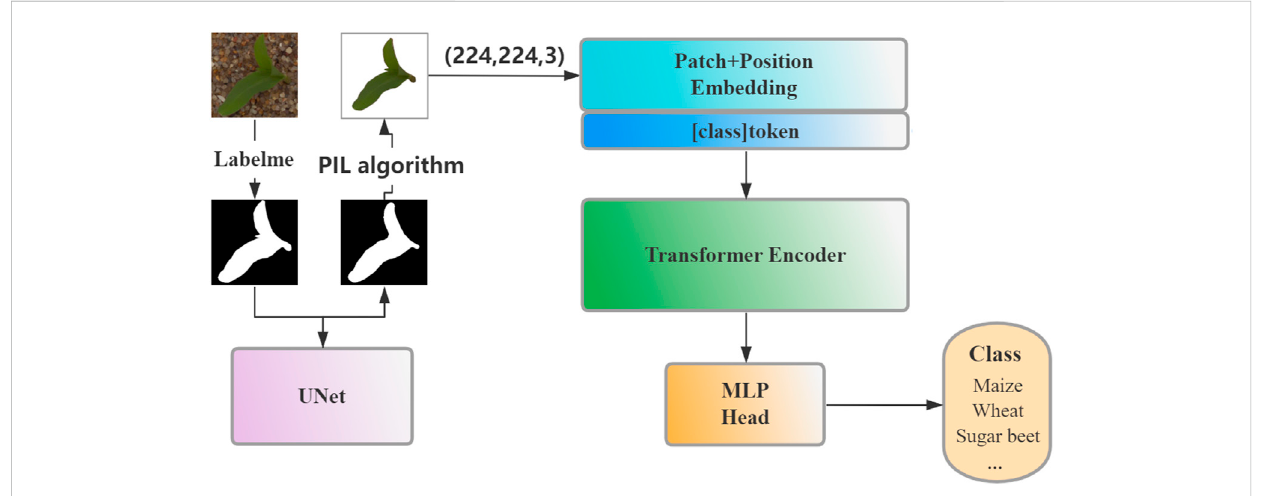
FIGURE 1 Flow Chart of maize and Wheat Seedlings and Field